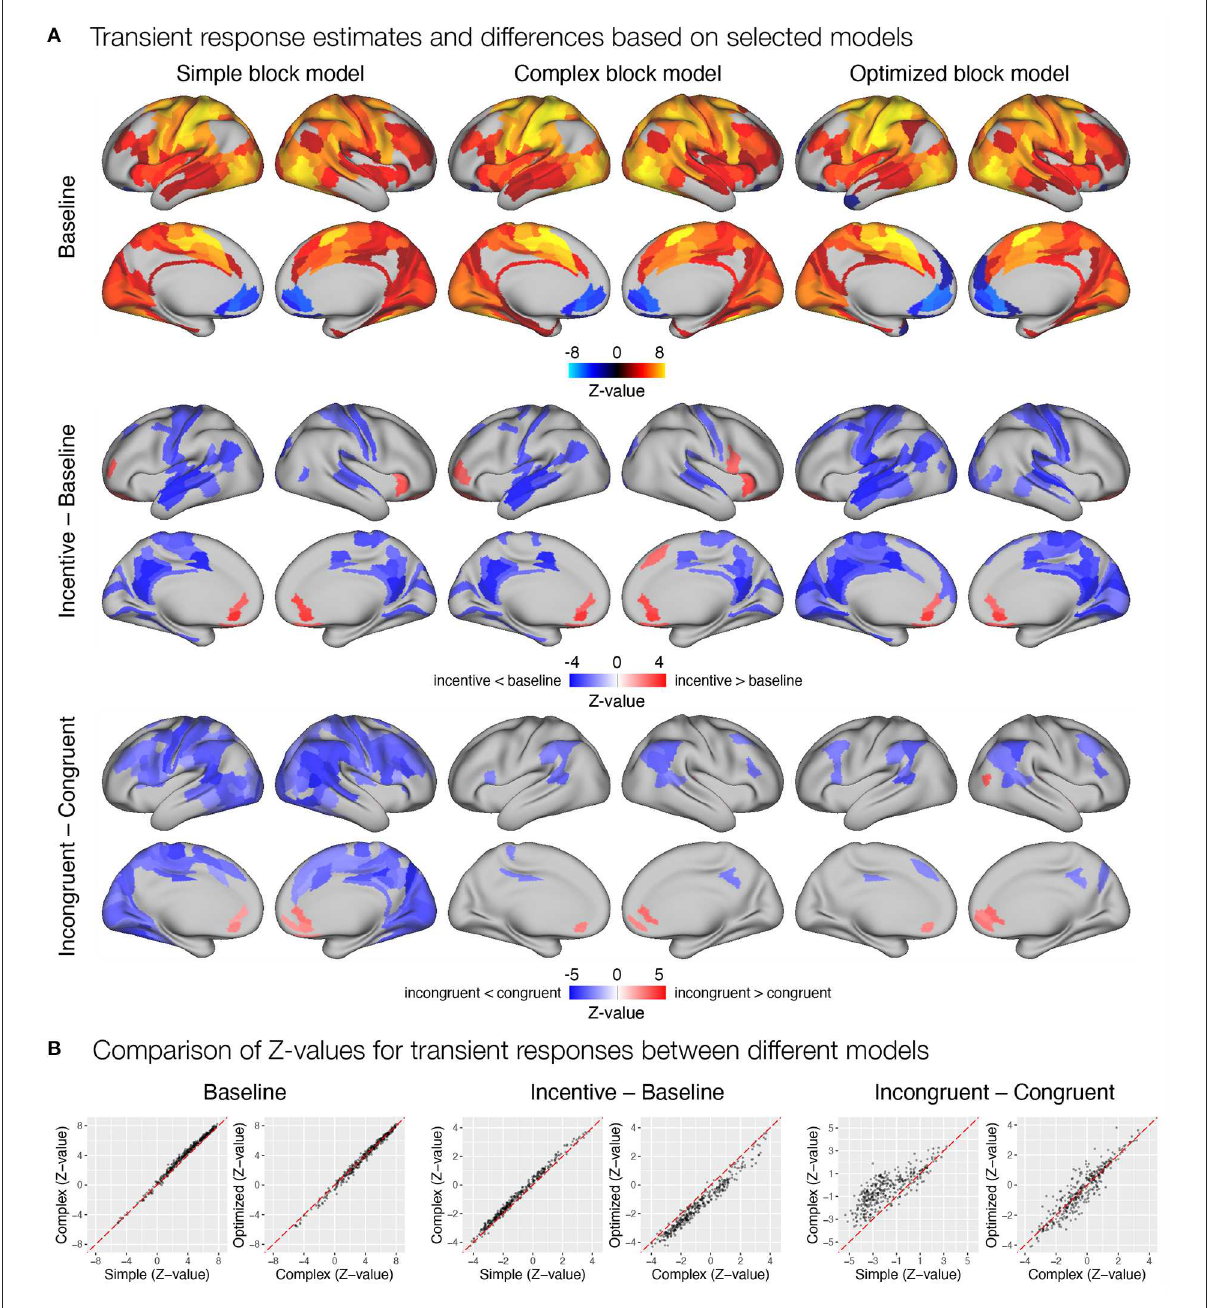
FIGURE9 Estimation of transient task response, incentive and stimulus congruency effects using different event models in the flanker study. (A) Significant transient whole-brain activations and deactivations in the baseline condition (top row), significant differences in transient response between incentive and baseline conditions (middle row), and significant differences between responses to incongruent and congruent stimuli in baseline condition (bottom row) are shown. (B) A comparison of Z -values obtained with different models. Each point represents a Z -value obtained for a brain parcel using the two models compared. The red diagonal presents equal